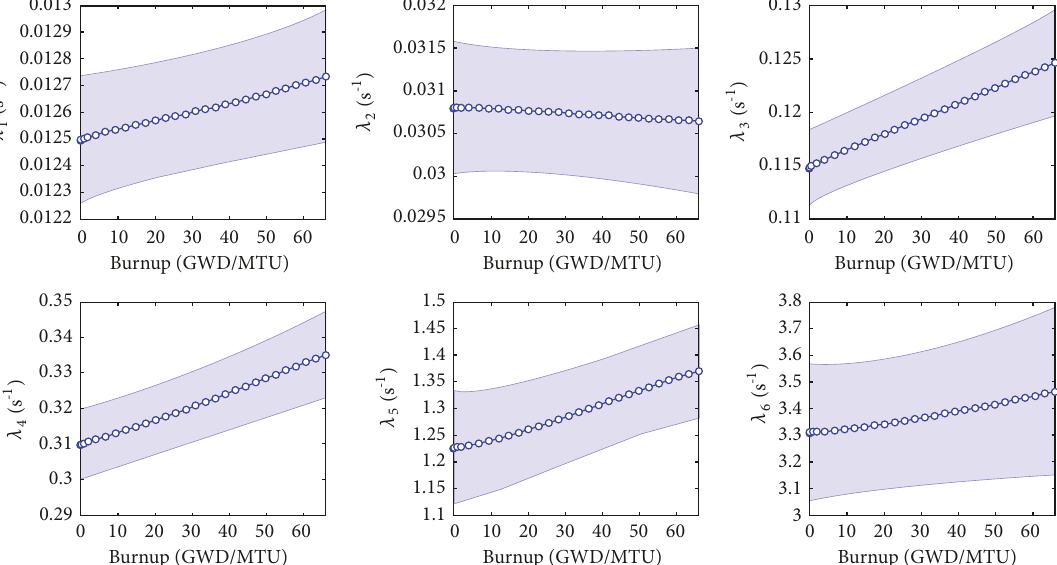
and new actinide isotopes appear in the fuel, which con- tributes to delayed neutron emission. Figures 6 and 7 show the group-wise DNF ( 𝛽 𝑖 ) and group-wise decay constant ( 𝜆 𝑖 ) as a function of burnup, respectively. The results presented in this subsection are based on the PWR lattice depleted to about 65 GWD/MTU with an average power of 33.6